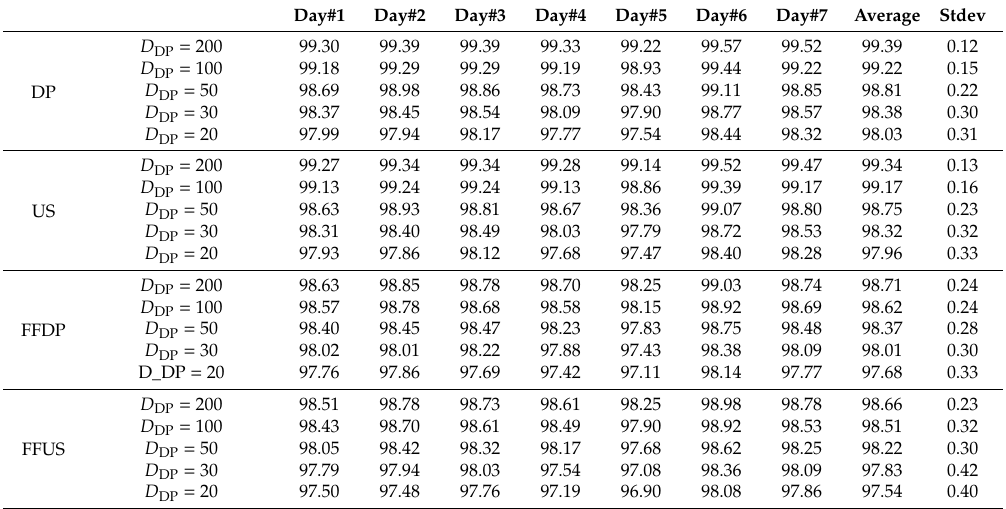
Table A3. Comparison of compression rates of di ff erent simplification